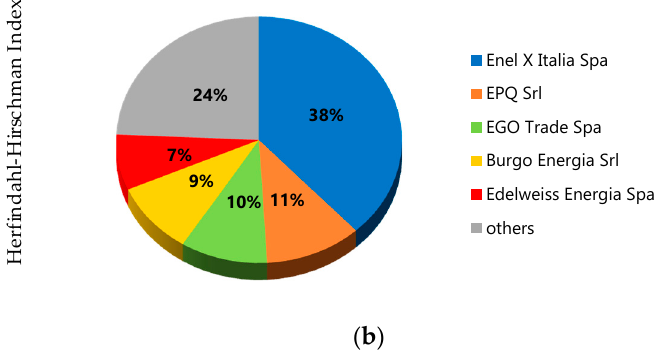
Figure 5. Development of number of UVAM auction participants during the first year of implementation in terms of: ( a ) Herfindahl–Hirschman index and ( b ) market share as of December 2019.